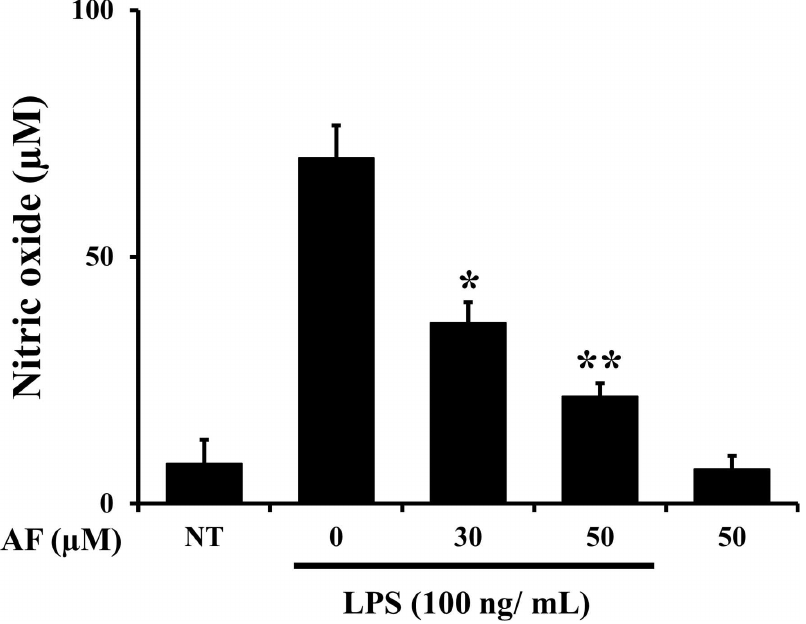
Fig 2. Effects of AF on LPS-stimulated NO production in RAW 264.7 macrophage cells. Cells (5 X 10 5 cells/well in 24-wellpate) were treated with LPS (100 ng/mL) only and with different concentrations of AF for 24 h. The amount of nitrite in the medium was measuredusing Griess assays. The values are expressedas the means ± SED. of three individualexperiments. * p < 0.05 and ** p < 0.01 indicatesignificantdifferences from the LPS alone-treated cells.